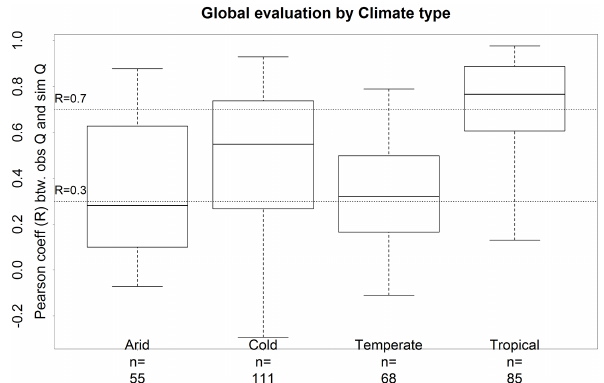
Figure 9. Global evaluation of the R score obtained during the validation and its classification − 2 only main types by the Köp- pen–Geiger climate area (Peel et al., 2007). Note that polar climate was excluded from this analysis as only three stations fell into this